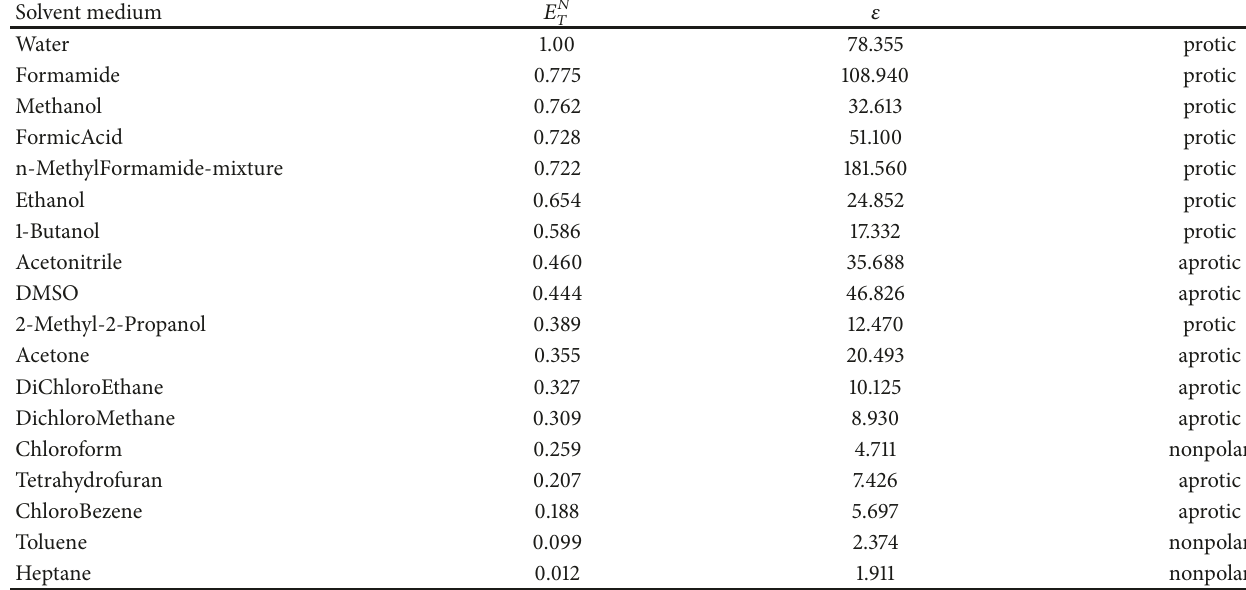
Table 2: Solvent media polarity parameter and static dielectric constant, as in ref. [16].